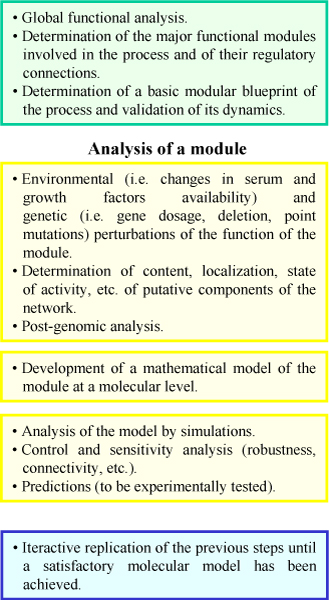
Scheme of the iterative roadmap of computational and experimental approaches applied in modular systems biology.